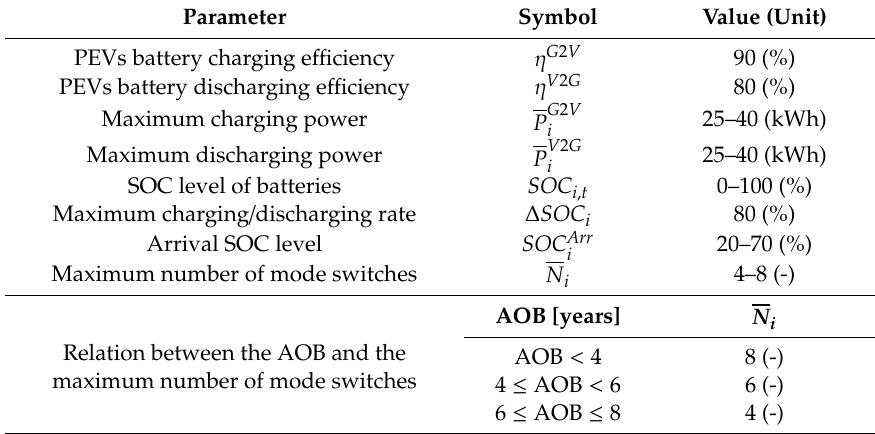
Table 2. Modelling parameters for the smart plug-in electric vehicles (PEVs) parking lot [23,24,28,31].